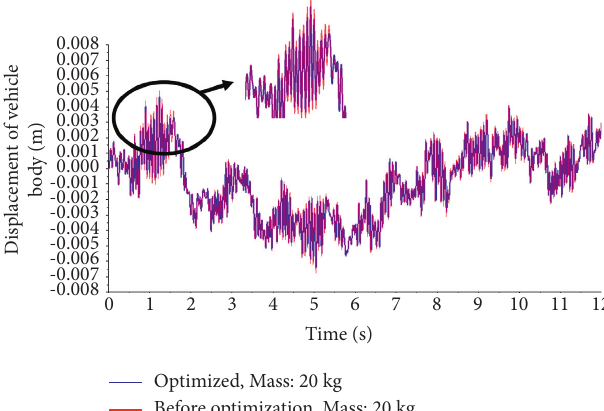
Figure 23: Comparison of the optimization results of the time-domain vehicle body displacement at a 20 kg load.